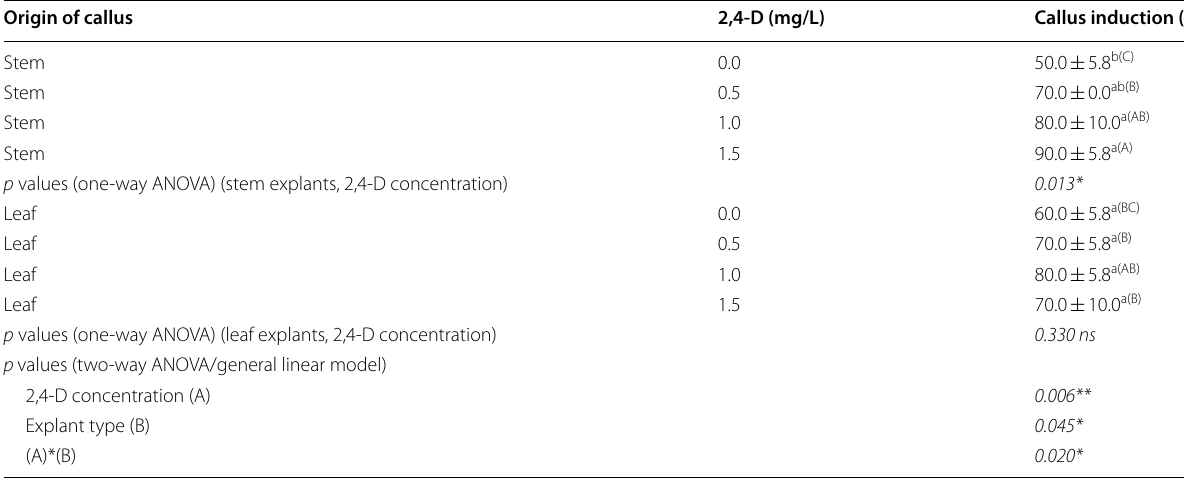
Means ( n 30) standard error (S.E.) with the same letter in a column are not statistically significant different from each other according to the Duncan’s multiple = ± range test at p 0.05. ns p > 0.05; * p 0.05; ** p 0.01. Superscript small letters—differences between four 2,4-D concentrations for each explant type (either stem or ≤ ≤ ≤ leaf) separately (one-way ANOVA). Superscript capital letters in parenthesis—differences between samples from the combined effect of two explant types (leaf,